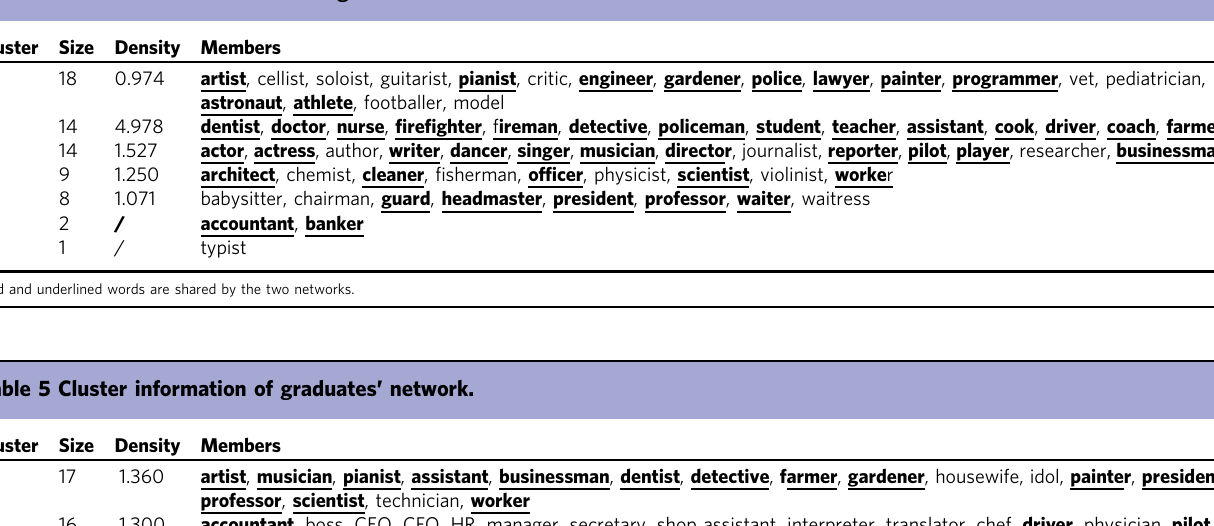
Table 4 Cluster information of undergraduates ’ network.